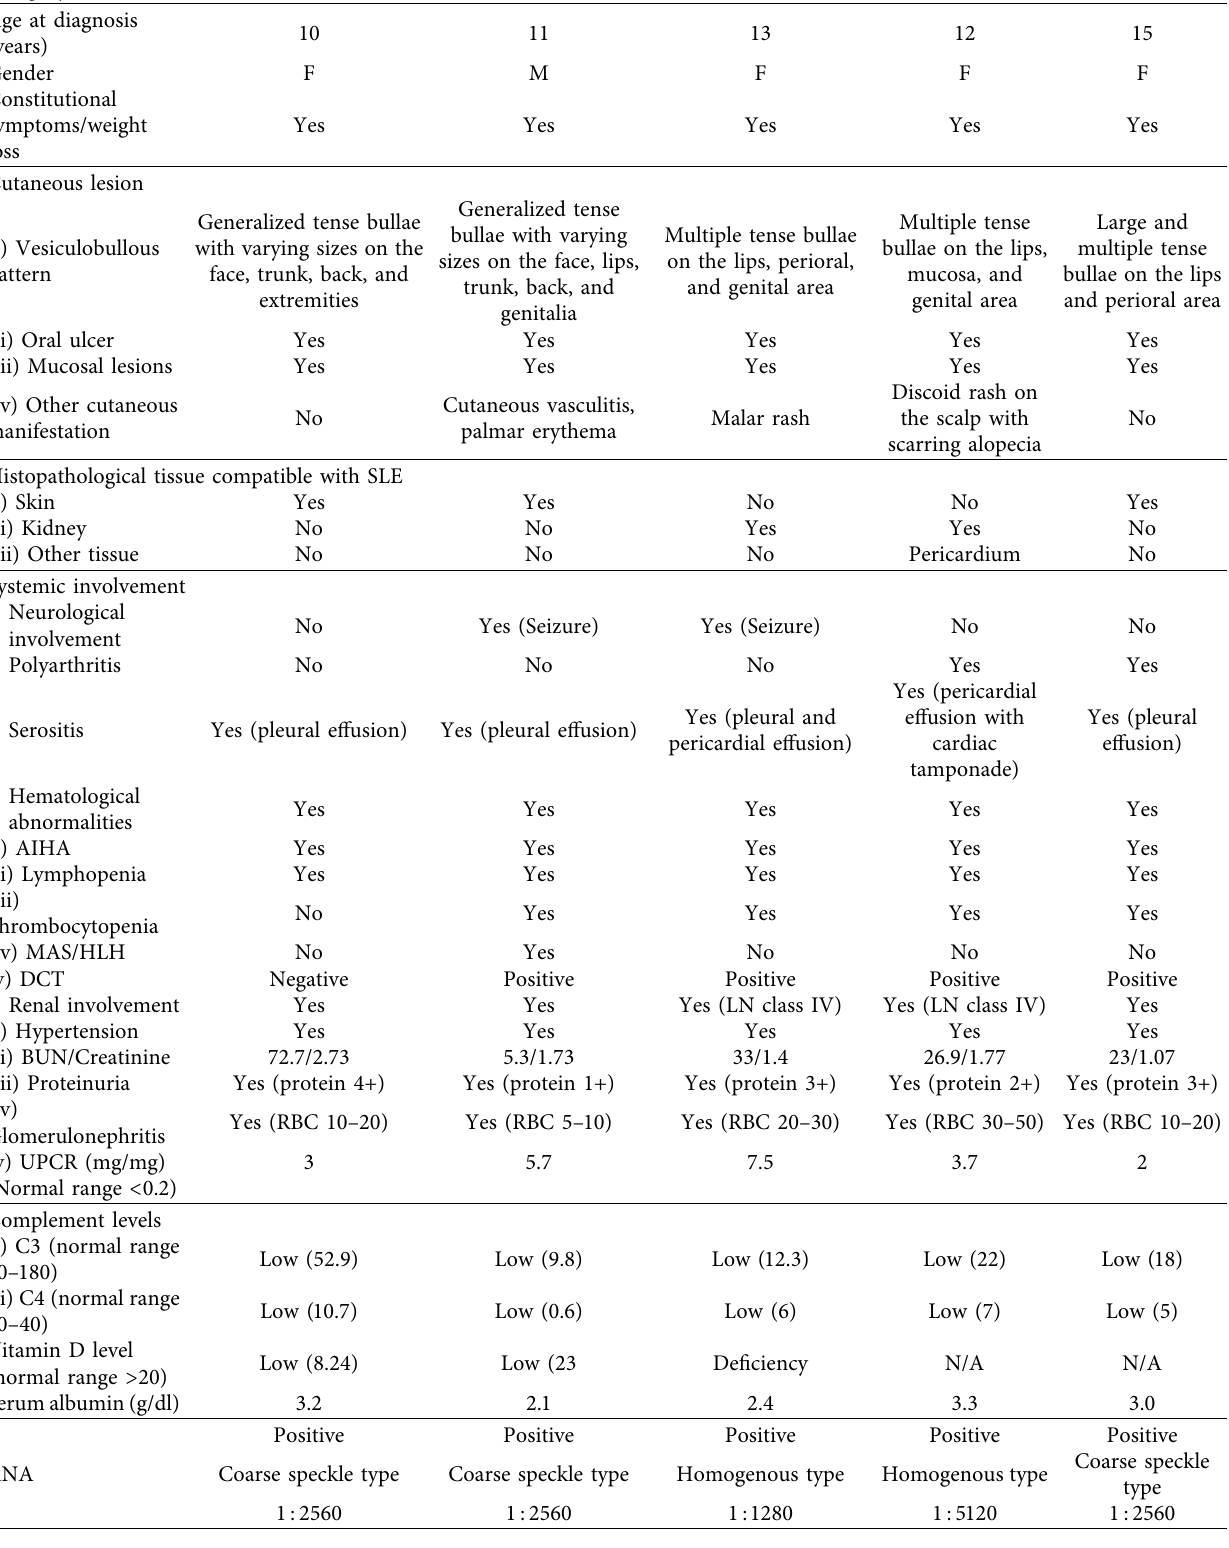
Table 1: Description of clinical characteristic, laboratory findings, treatments, and outcomes of pediatric BSLE patients in the study population. Category Gender